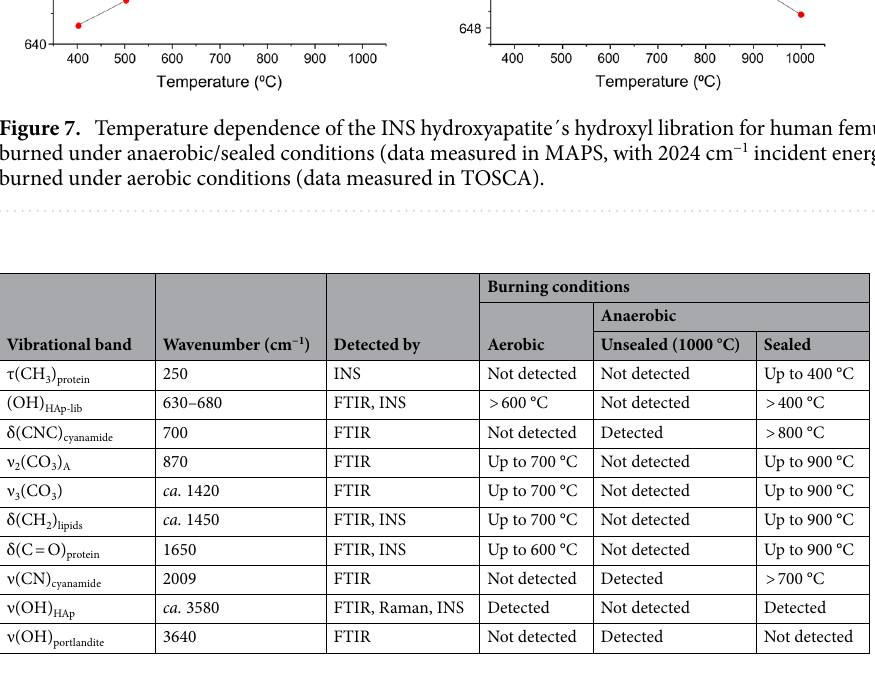
Table 1. Main changes detected by vibrational spectroscopy (FTIR-ATR, Raman and INS) in samples from human bones burned under different conditions—aerobic, anaerobic/sealed chamber and anaerobic/unsealed